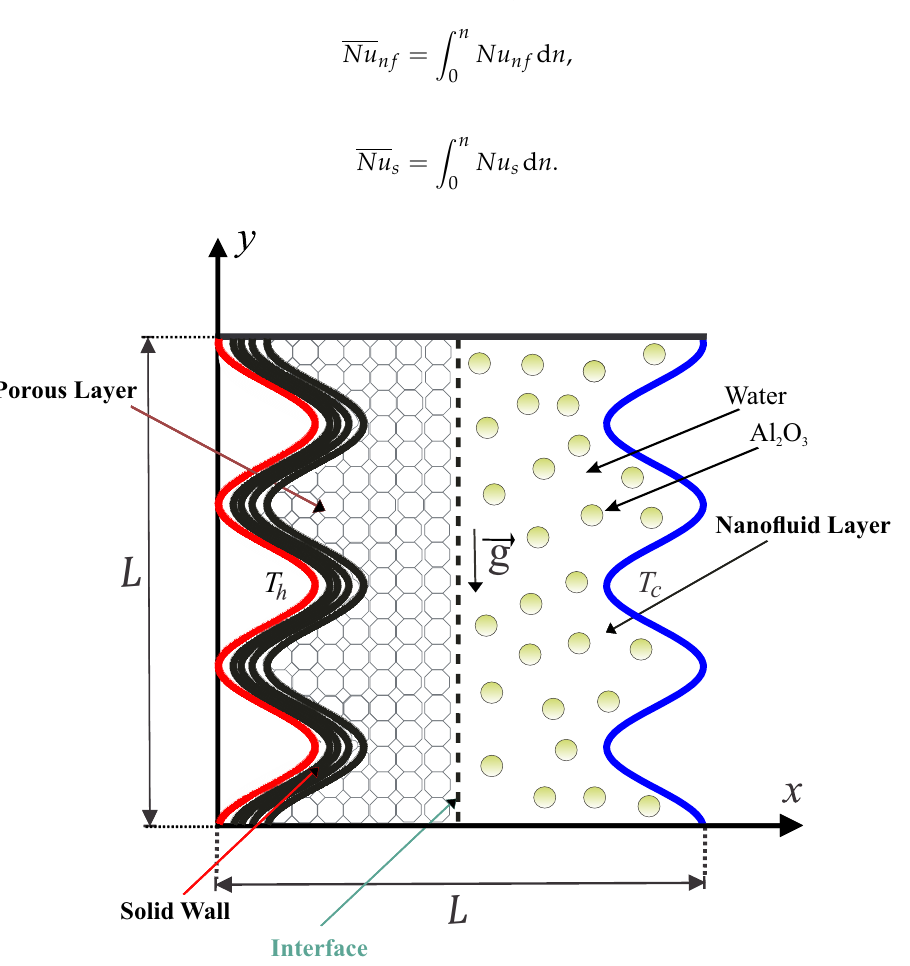
Figure 1. Schematic representation concerning the convection flow in the wavy-walled